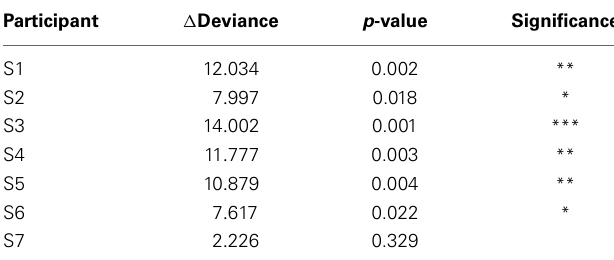
Table 5 | χ 2 difference test of model M fixed vs. model M var for each participant. The nested model ( M fixed ) has two fewer degrees of freedom: linear and quadratic coefficients for the modulation of slope over the course of training.